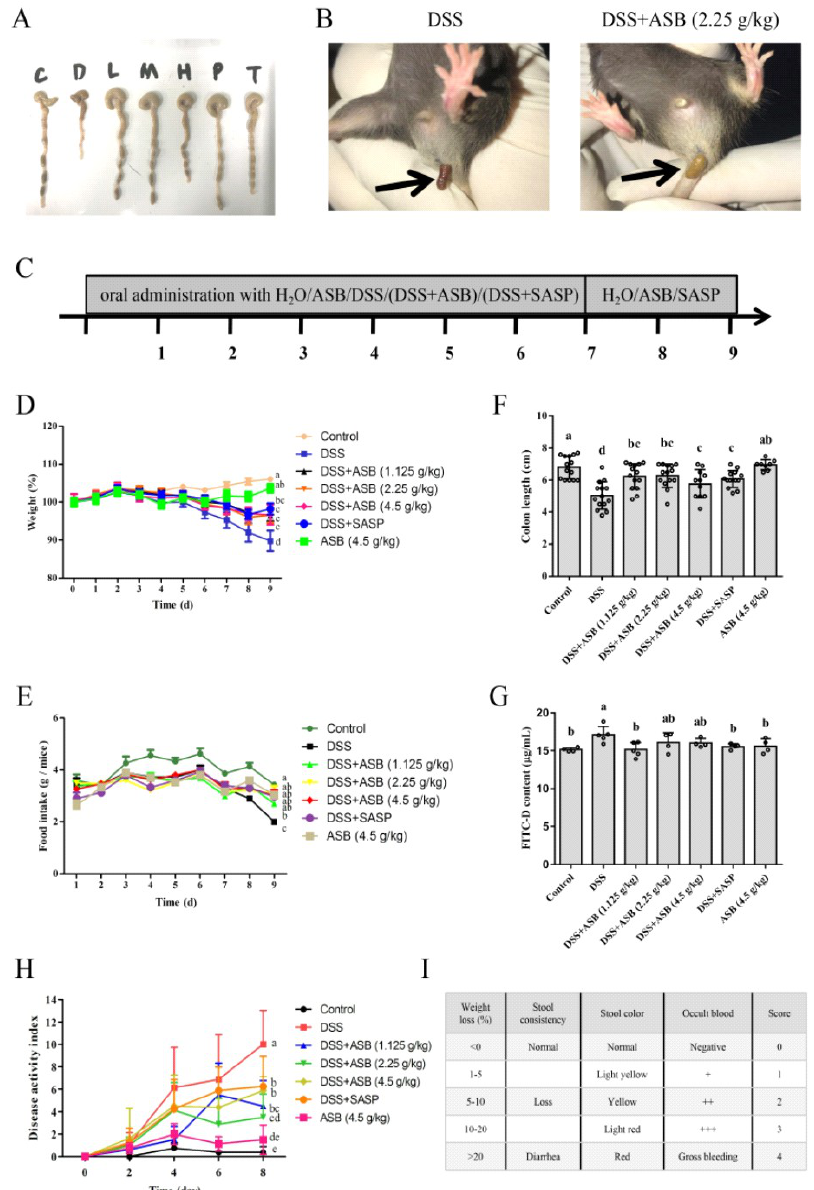
Figure 2. ASB protects against DSS-induced colitis in mice. ( A ) Representative photographs of colon (C: control, n = 14; D: DSS model, n = 14; L: DSS + ASB low dosage, n = 14; M: DSS + ASB medium dosage, n = 14; H: DSS + ASB high dosage, n = 14; P: SASP, n = 14; T: ASB high dosage reference, n = 8). ( B ) E ff ect of ASB on rectal bleeding in DSS-treated mice at day 7. ( C ) Schematic representations of the colitis model. E ff ect of ASB on body weight ( D ), daily feed content ( E ) and colon length ( F ) at the end of the experiment. ( G ) E ff ect of intestinal permeability upon ASB treatments at the end of the experiment. ( H ) Disease activity index (DAI) evaluation of mice in each group. ( I ) The scoring criteria for DAI. Results were expressed as mean ± SD. Parameters marked by the same letter are not significantly di ff erent. Significance is represented as p <